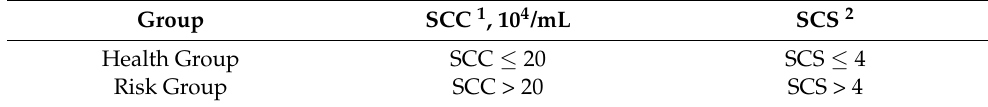
Table 3. Disease grouping of Holstein cows. Group SCC 1 , 10 4 /mL SCS 2 Health Group SCC ≤ 20 SCS ≤ 4 Risk Group SCC >